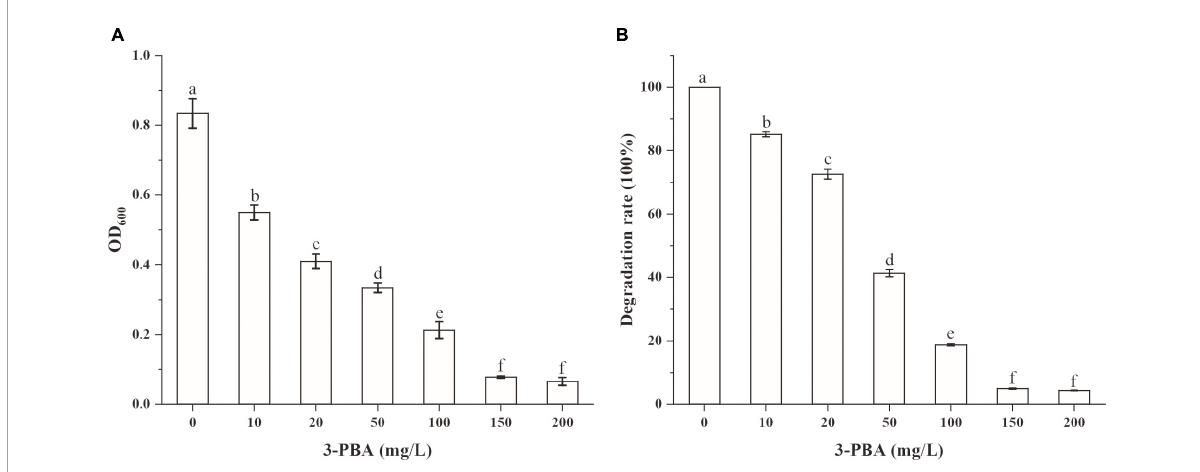
FIGURE3 The effect of 3-PBA on the growth of strain JQ-L (A) and cypermethrin degradation by strain JQ-L (B) . Different lowercase letters indicate significant difference under P < 0.05.